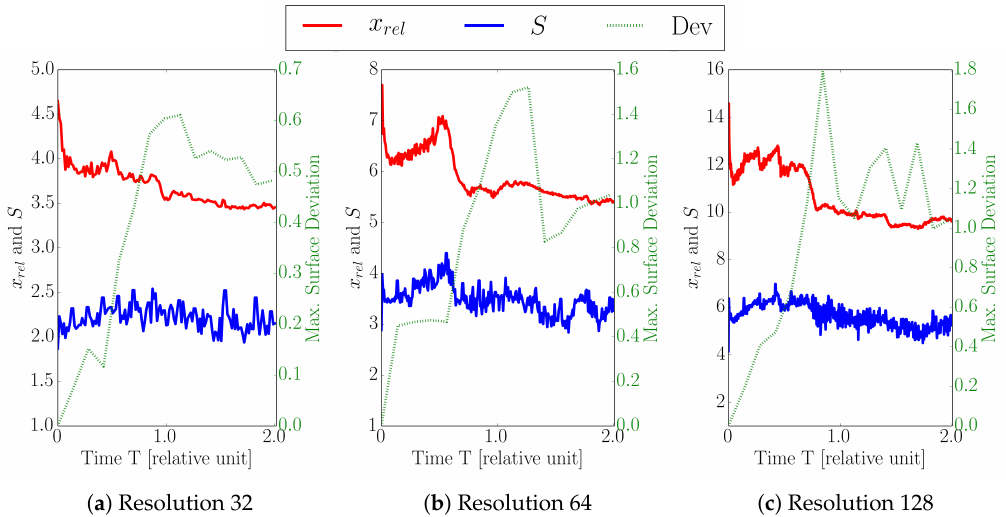
Figure 9. Ratio between dense and sparse number of cells x rel , Speedup S , and maximum surface deviation (Dev) for level-set resolution of ( a ) 32, ( b ) 64, and ( c ) 128 using the default values for both refinement conditions ( t flux = 10% and t angle = 0.1). The average values are depicted in Figure